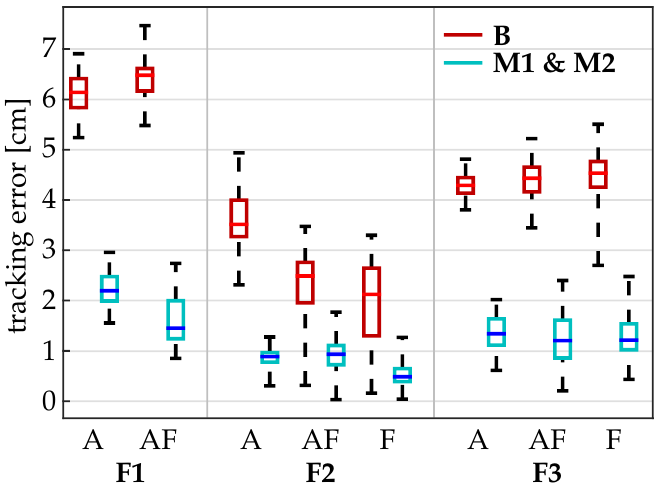
Figure 12. Median, 25th and 75th percentile and maximum values of the error E between the optical motion capture measurement and the hand sensor system with method B (red) and M1 and M2 (blue) for all conducted experiments with the volunteer in Setting 1. For a better overview, methods M1 and M2 were summarized, whereby the respective higher value was illustrated. Box-plots were calculated over time intervals of 30 seconds with at least 10 repetitions for each movement. Abbreviations: A: abduction, F: flexion, AF: abduction and flexion motion, F1: thumb, F2: index finger, F3: middle finger.